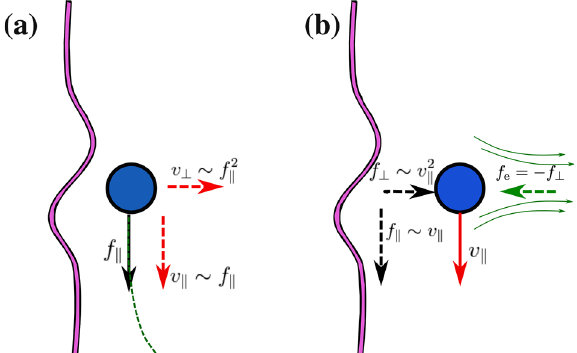
moves near a soft (cid:31) . The (cid:31) f to the particle. This hydrodynamic pushing force = − ⊥